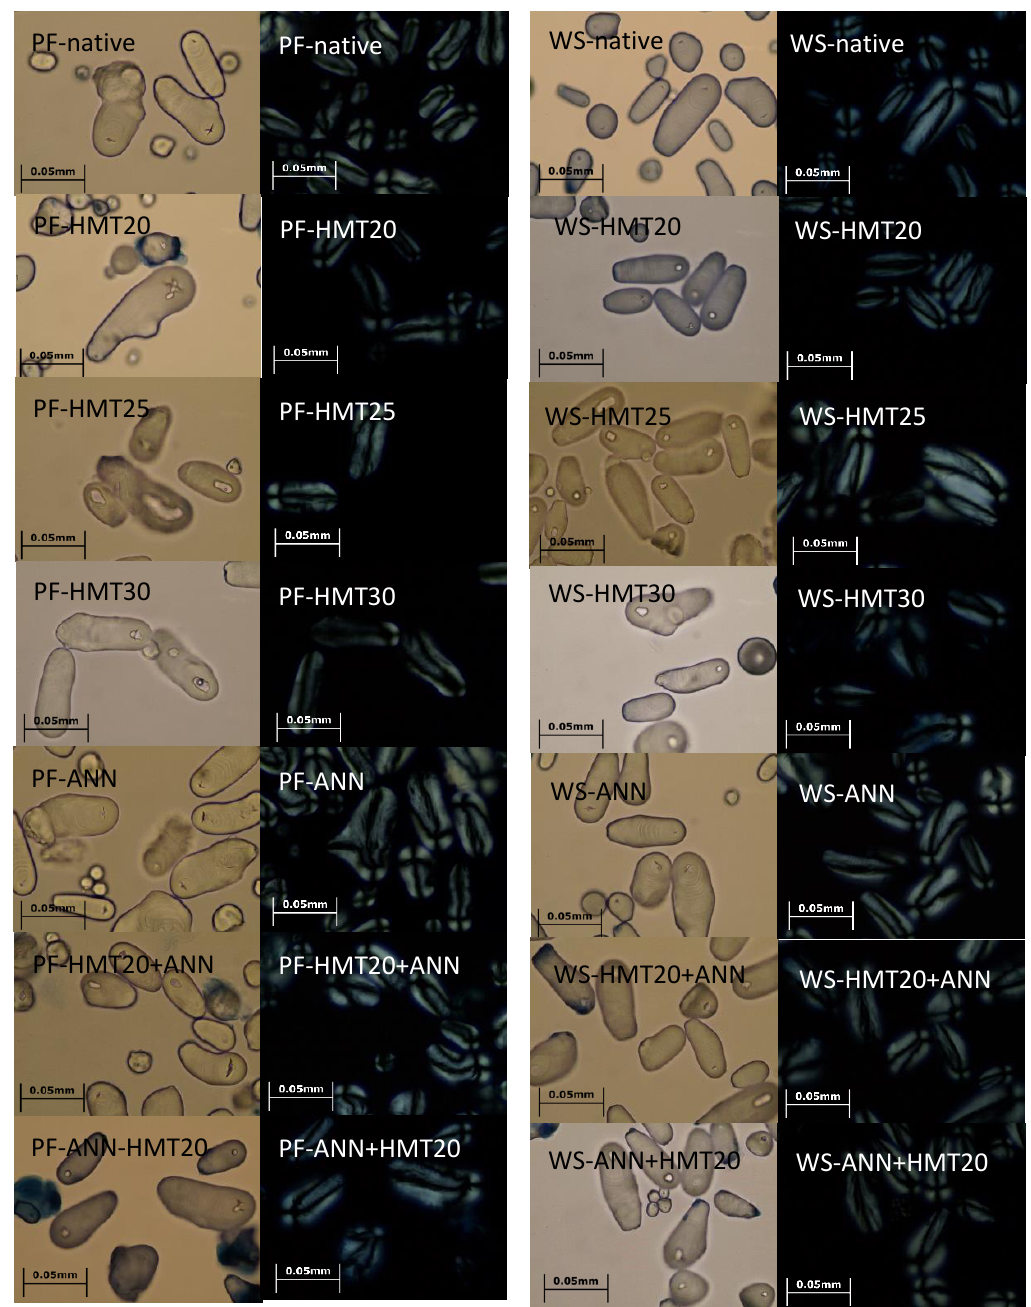
Figure 2. Granule appearance and birefringence photomicrographs of native and modified lotus rhizome starches (400×).